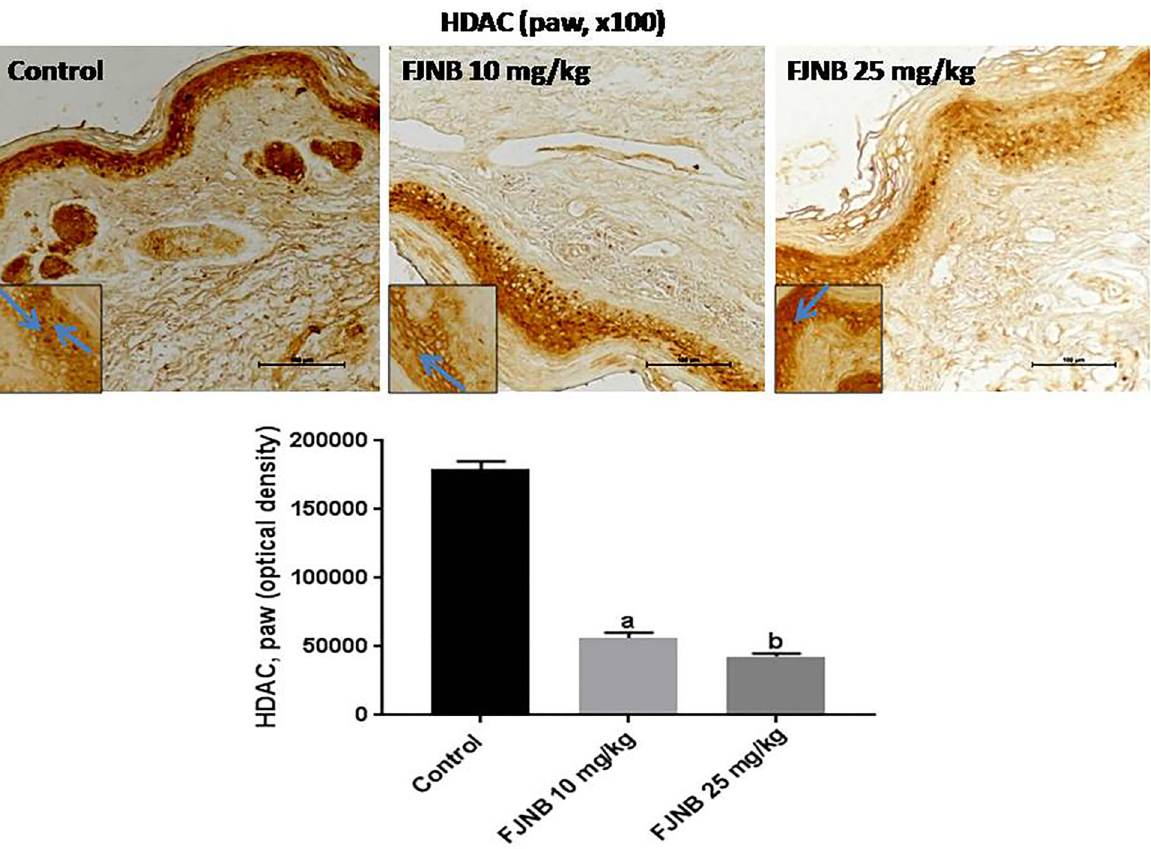
Figure 8. The triterpene-rich fraction from Himatanthus drasticus (FJNB) inhibited immunostaining for histone deacetylase (HDAC) in in fl amed paws (Controls) from the formalin test in mice. Representative photomicrographs ( (cid:1) 100 magni fi cation, scale bar, 200 m m). The inserts were taken at (cid:1) 400 magni fi cation and blue arrows show polymorphonuclear cells. Data are reported as means ± SE for 3 different animals. a,b P o 0.0001 vs Control (one-way ANOVA and Tukey ’ s test for multiple